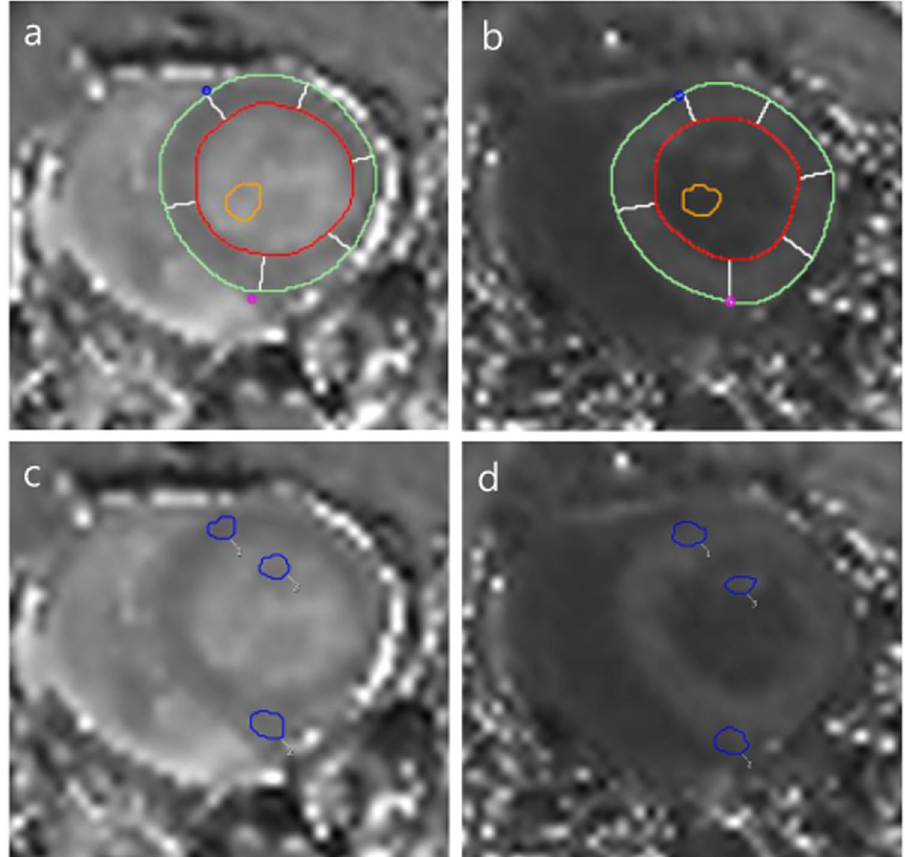
Figure 6. Measurement of T1 values in the myocardium and specific lesions of the left ventricle (LV) at the mid-ventricle on the short-axis plane. Endocardial (red line) and epicardial borders (green line) of the LV wall were delineated semi-automatically; six segments were delineated automatically (white lines). A round < 5 mm 2 region of interest (ROI; orange circle) was drawn in the LV cavity on pre-contrast ( a ) and post-contrast T1 mapping images ( b ). To measure T1 values of specific LV lesions in the short-axis plane, ROIs covering specific lesions (blue circle 1: right ventricle (RV) upper insertion site, 2: RV lower insertion site, 3: papillary muscle) were drawn on pre-contrast ( c ) and post-contrast T1-mapping images ( d